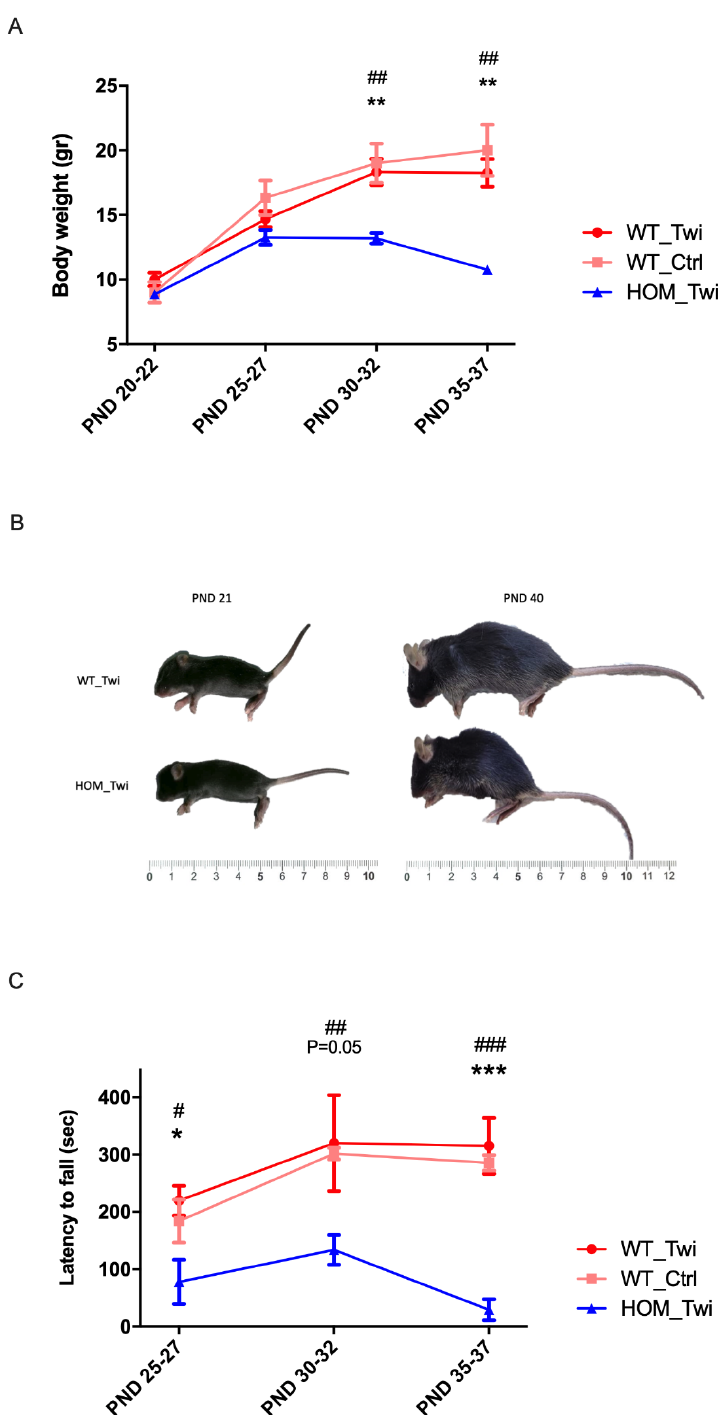
Figure 5. ( A ) Body weight versus post-natal day (PND). Body weight (BW) was measured (in grams) every 5 days. ** p < 0.01 WT_Twi versus HOM_Twi; ## p < 0.01 WT_Ctrl versus HOM_Twi. ( B ) Representative image of WT_Twi (top) versus HOM_Twi mouse (bottom) at PND 22 and PND 40. ( C ) The Rotarod test was performed on HOM_Twi, WT_Twi, and WT_Ctrl mice every 5 days. Data are reported in the graph in seconds (s). * p < 0.05, *** p < 0.001 WT_Twi versus HOM_Twi; # p < 0.05, ## p < 0.01, ### p < 0.001 WT_Ctrl versus HOM_Twi. Data are reported as mean ± SEM and compared using a